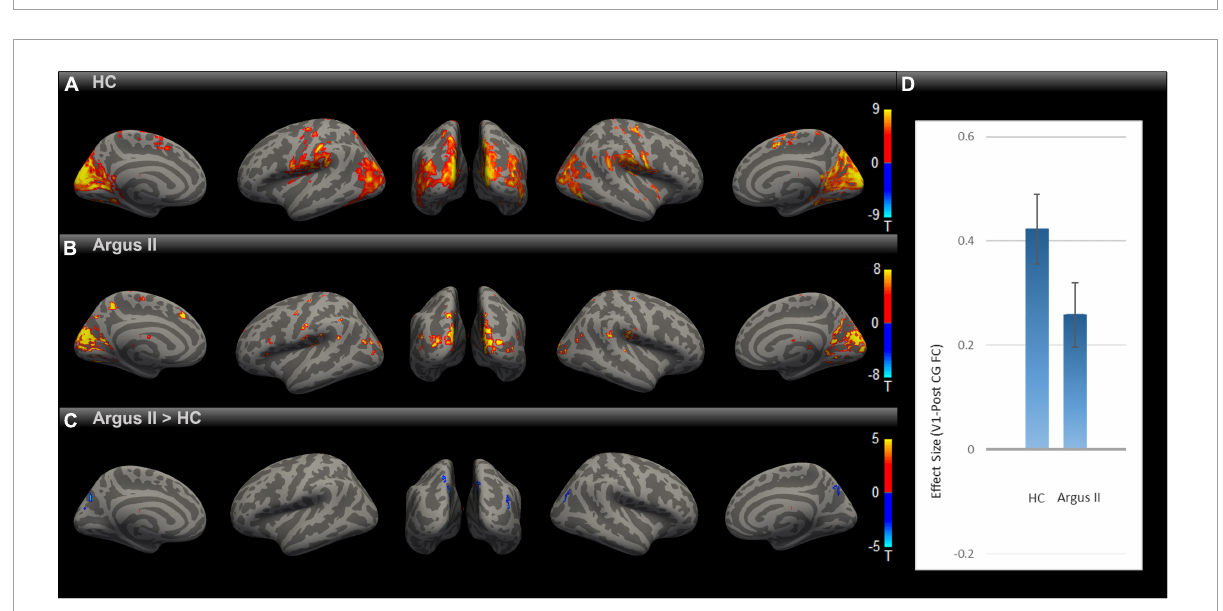
FIGURE3 Comparing rsFC between Argus II and HC. Using the V1 seed, the group-level rsFC maps for Argus II (A) , HC (B), and Argus II > HC contrast (C) were corrected for multiple comparisons using the Gaussian Random Field Theory with an uncorrected voxel-level threshold of p < 0.001 and a cluster-level threshold of p < 0.05 FDR corrected for cluster size. The contrast map shows that the areas depicting lower rsFC to V1 were found in some higher-level visual areas (shown in blue). The ROI-to-ROI rsFC analysis (D) revealed no significant difference in the V1-PostCG rsFC effect size between Argus II and HC groups, t (15) = –1.72, p = 0.1.